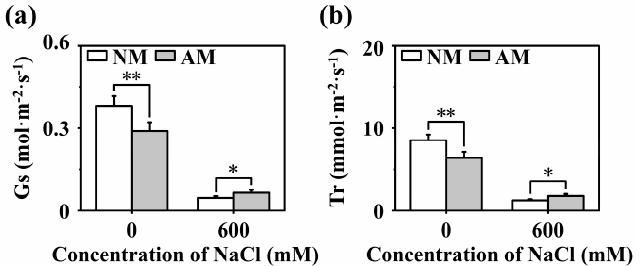
Figure 3. The stomatal conductance (Gs) and transpiration rate (Tr) in leaves of C. glauca in different treatments. ( a ) The Gs in leaves of C. glauca in different treatments. ( b ) The Tr in leaves of C. glauca in different treatments. NM, nonmycorrhizal; AM, inoculated with R. irregularis ; 0, no NaCl stress; 600, 600 mM NaCl stress. The data are the means ± standard errors ( n = 3). * indicates significant differences between means at the p < 0.05 level by one-way ANOVA, and ** indicates significant differences between means at the p < 0.01 level by one-way ANOVA.